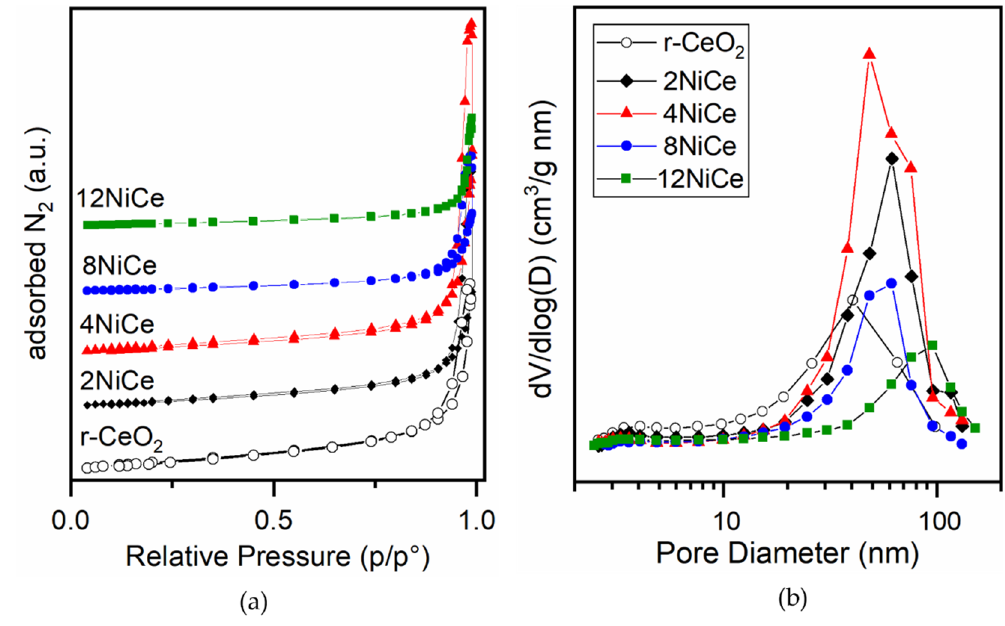
Figure 5. ( a ) N 2 adsorption–desorption isotherms and ( b ) pore size distribution (PSD) of reduced NiCe-R samples. Table 5. Surface area and pore morphology of reduced samples.